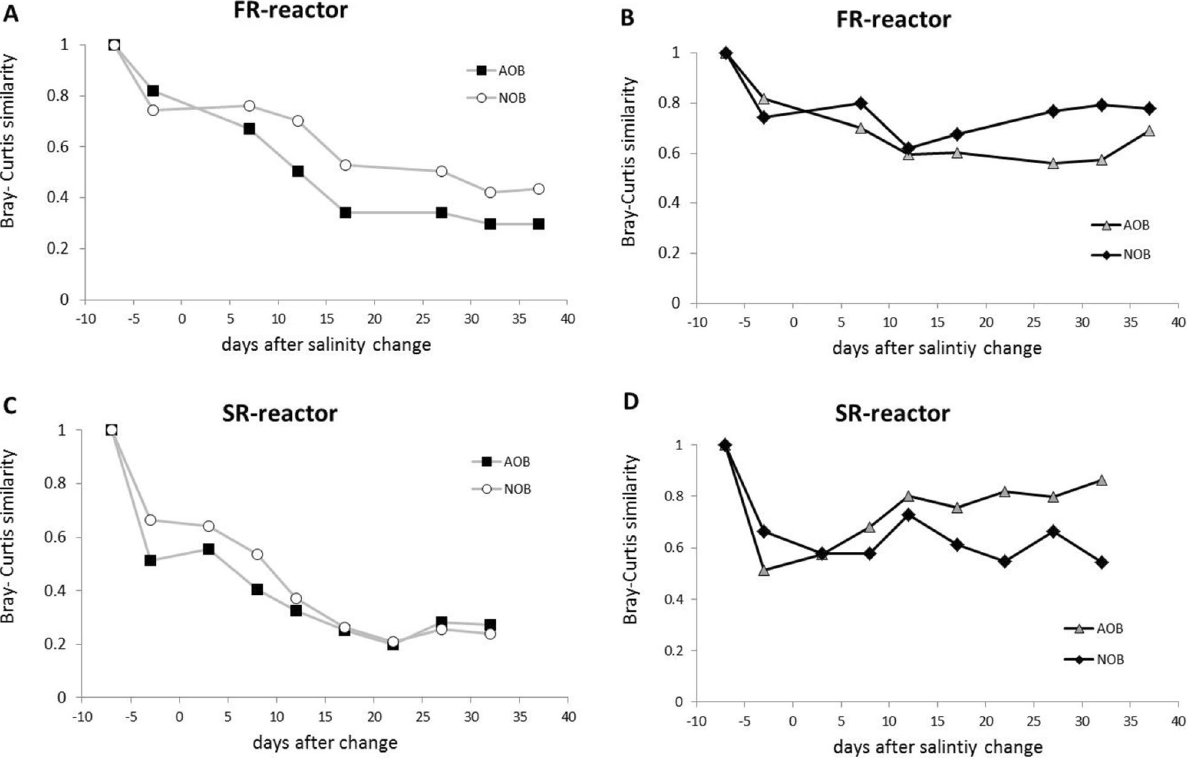
Figure 4. Succession of the microbial community. ( A ) Bray–Curtis similarity between all samples versus the initial F5 sample in the FR reactor. ( B ) Bray–curtis similarity based on comparison with previous/next sample in time for the FR reactor. ( C ) Similar to panel ( A ) but for SR reactor using S5 sample as reference. ( D ) Similar to panel ( B ) but for the SR samples of the FR-end was significantly lower than for the other three groups (Fig. 5A). The Shannon’s diversity index for the total community was significantly higher for the samples of the FR-end than for the FR-start, whereas Shannon’s diversity index in the nitrifying community was highest for the samples of the FR-end and SR-start (Fig. 5B). The average Bray–Curtis similarity calculated within each of the four clusters of nitrifying communities was high (0.6–0.75), whereas the similarities were low for comparisons of the samples between the –end and –start clusters (0.36–0.24), indicating large changes in the nitrifying communities after salinity change in both reactors (Fig. S3; Supplemental Material). SIMPER analysis showed that the 10 most significant OTUs contributed 92.7% of the total difference between the community clusters (Table 2). The 4 most influential of these OTUs contributed 75% of this difference. The relative abundance of these 10 OTUs in each cluster is summarized in Table 2. A phylogenetic analysis (Fig. S2, Supplemental material) identified the closest relatives of these 10 AOB and NOB OTUs (Table 2). The largest change in abundance of the most dominant AOB and NOB OTUs was observed in the SR-start and SR-end clusters, with a dramatic increase in abundance of an OTU related to Nitrosoccus mobilis . Interestingly, the abundance of this OTU also increased in the FR reactor. In FR, the abundance of an OTU (1124569) representing Nitrospira decreased from 67 (FR-start) to 24% (FR-end), while the abundance of a Nitrobacter OTU (220928) increased three-fold. Venn diagrams were constructed to find the number of shared and unique OTUs among the groups (Fig. 6). We observed that both the fraction of shared OTUs and the abundance of those OTUs were important for explaining the differences between the groups. In most of the cases, the shared OTUs were highly abundant only in one of the groups (Table 2). For the FR-start and end, the Venn diagram indicated that these clusters shared 60 and 55% of AOB and NOB OTUs, respectively, of the total found in both clusters (Fig. 6A). However, only the AOB OTU 6540, closely related with Nitrosomonas sp., and the NOB OTUs 1124569 and 220928, closely related with Ca. Nitrospira and Nitrobacter sp., respectively, where highly abundant in both clusters (Table 2). The SR groups, on the other hand, shared 42 and 27% of AOB and NOB OTUs, respectively, of the total found in both groups (Fig. 6B). However, different OTUs dominated by both groups. The SR-start was dominated by OTUs closely related to Nitrosomonas aestuarii and Ca. Nitrospira salsa (OTUs 27,445 and OTU758679; Table 2), whereas SR-end by OTUs closely related to Nitrosococus mobilis and Ca. Nitrospira , respectively, (OTUs 18274 and 1124569; Table 2). FR-start and SR-end samples represent two well-functioning cultures at freshwater conditions, but with dif- ferent adaptation regime and inoculum (see “Sources of biomass and sampling” section). The FR-start samples were enriched in a freshwater environment for several years, see “Sources of biomass and sampling” section,